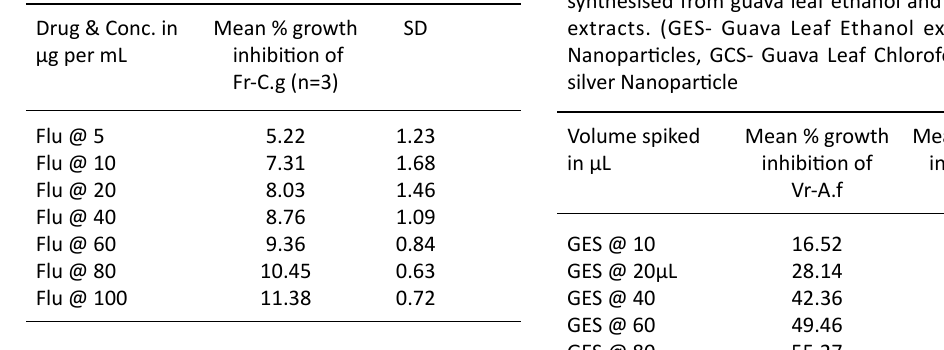
Table 5. Anti-fungal activity of Guava leaf extracts ( GE- Guava leaf Ethanol extract, GC- Guava leaf Chloroform extract) Conc. in